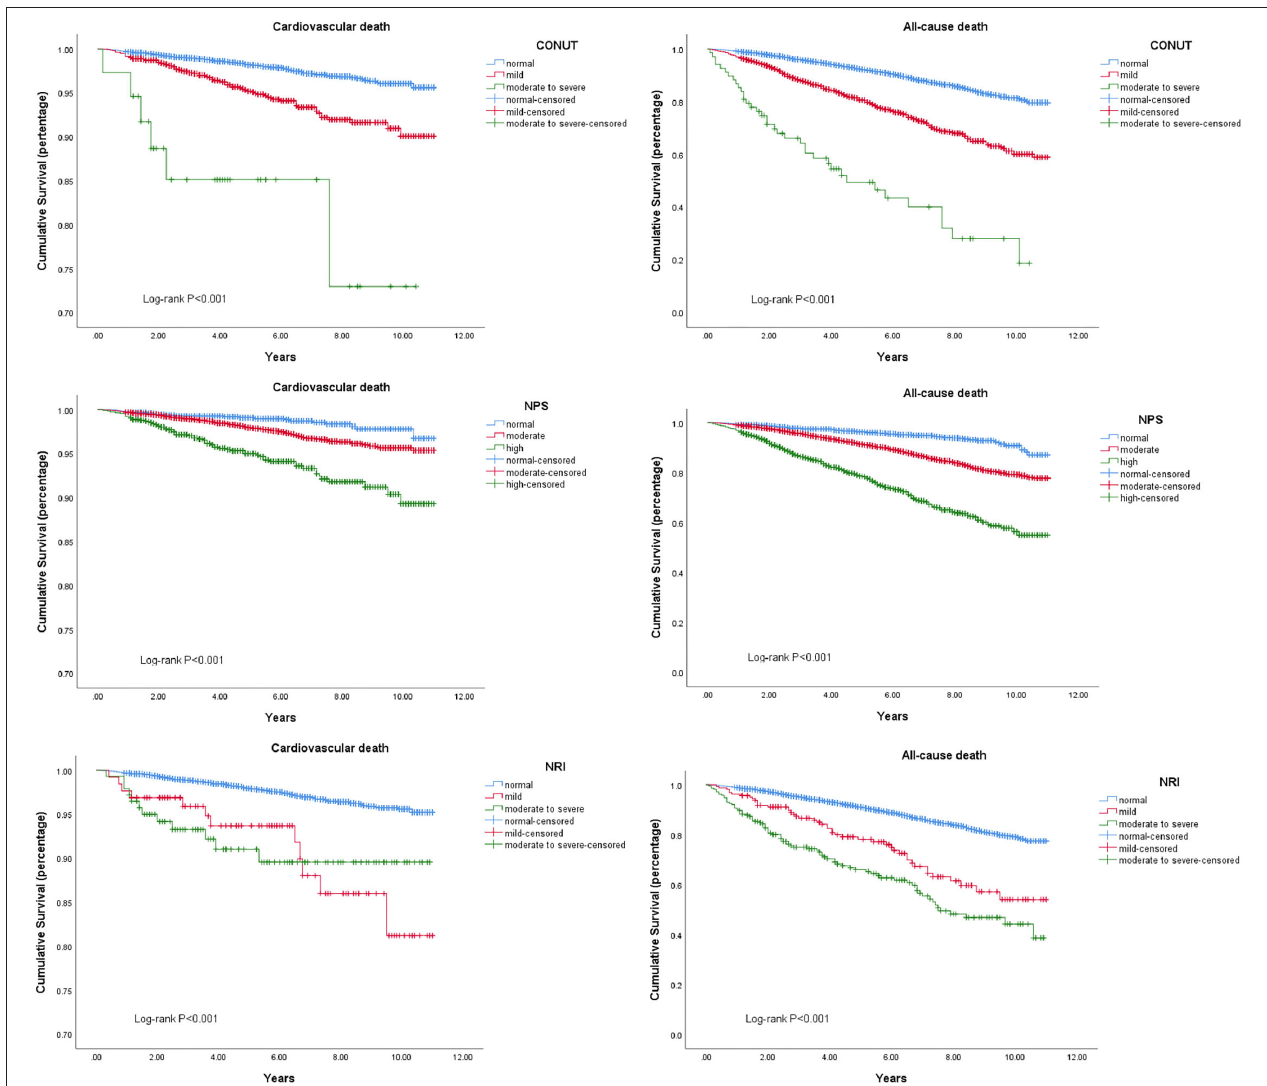
FIGURE 3 | Kaplan–Meier curves of long-term cardiovascular and all-cause mortality for different nutritional status assessed by three nutritional screening tools.